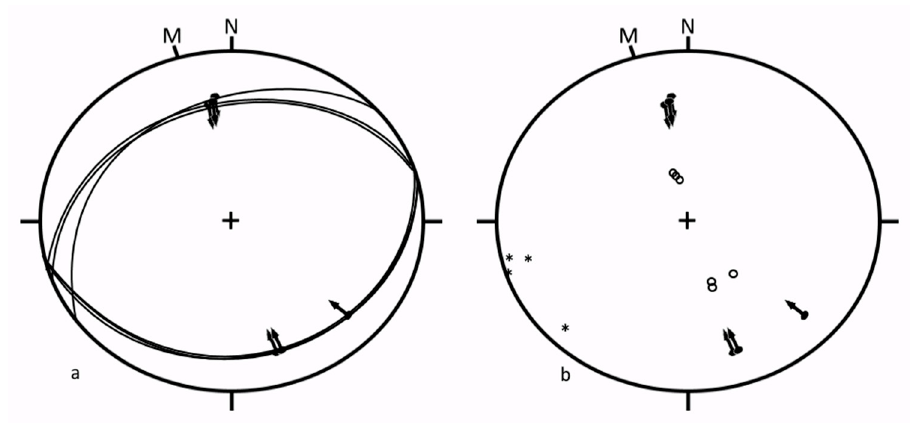
Figure 8. Regime 8. Lower Hemisphere Equal Area projection of ( a ) great circles of fault planes and ( b ) of poles to fault planes (open circles) and of calculated trend and plunge (*) of σ 2. Symbols are as in Figure 3.